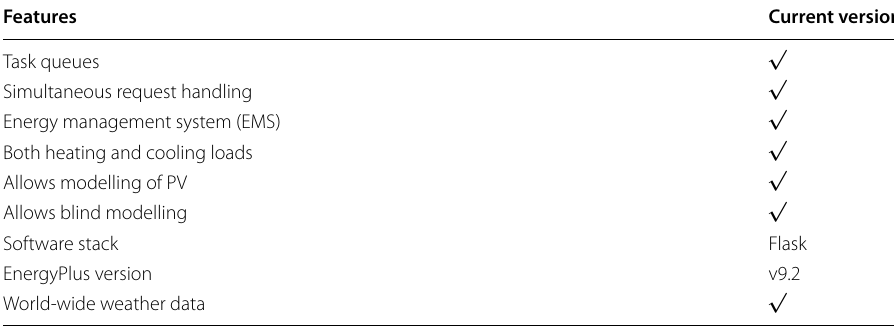
Table 2 Features of the tool Features